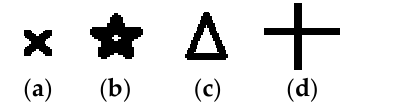
Figure 7. Compression Quality Vs BER in the case of different watermark sizes.